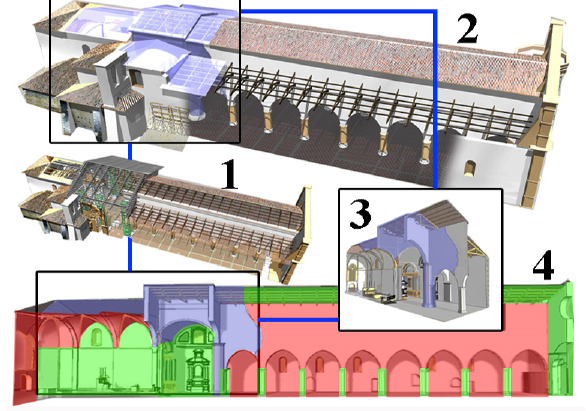
Fig. 9 Visconti bridge: Revti model (1), BIM for structural analysis (2), BIM for VR/AR (3) and BIM for Monitoring (4). In red the elements where GoG 10 has been used, in green GoG09 and in blue the other types of GoGs.